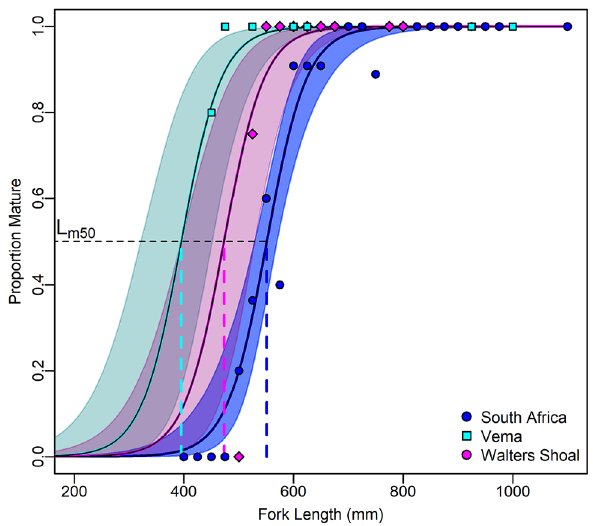
Figure 5. Logistic maturity ogives showing observed (symbols) and predicted (solid lines) -lengths-at-maturity for female yellowtail from South Africa, Vema and Walters Shoal sampling localities. Colour-coded translucent areas denote the 95% confidence intervals the respective sampling locality. Colour-code dashed lines depict the estimated lengtht-at-50%-maturity ( L m50 ) for each locality. Differences in the colour gradients of shaded areas result from overlaps in 95% confidence